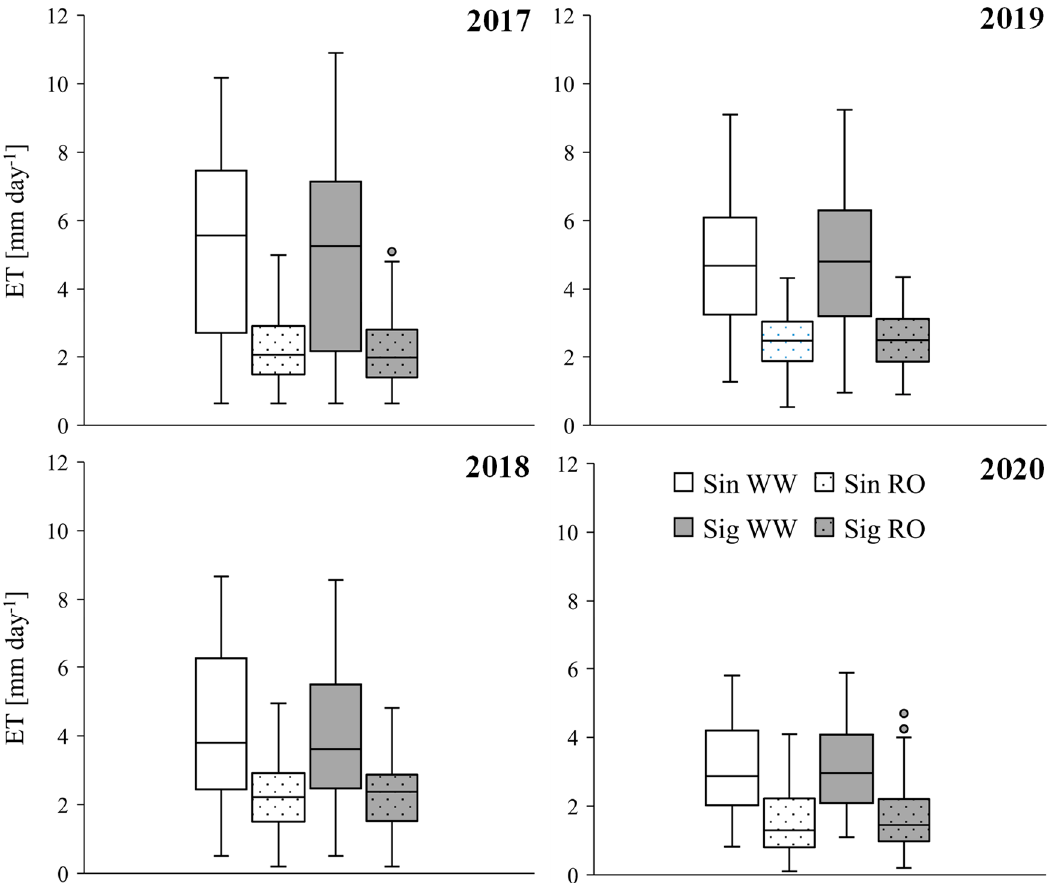
Figure 2. Daily mean evapotranspiration rates, ET [mm] under unlimited (WW) and water stress (RO) conditions in varieties Sinara (Sin) and Sigalia (Sig) during dry (upper row 2017 and 2019) and wet (lower row 2018 and 2020) growing seasons at Keszthely, Hungary.